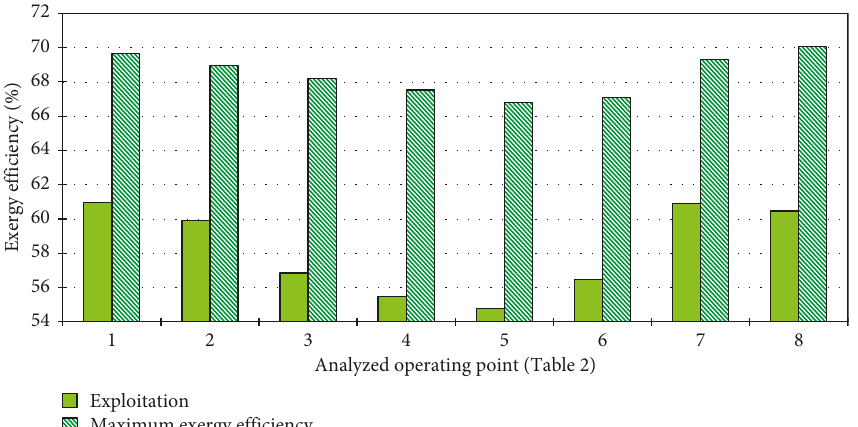
Figure 12: Comparison of exergy efficiencies for all analyzed operating points—exploitation versus maximum exergy efficiency phase.